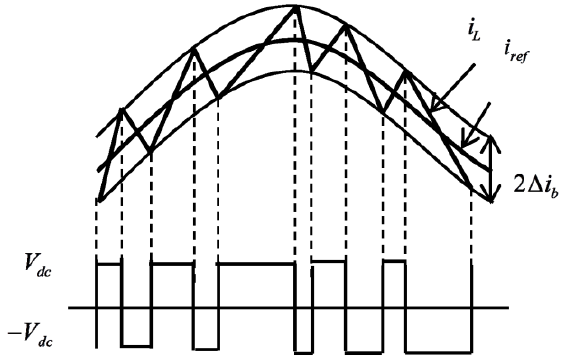
Figure 3. Fixed band hysteresis current control.